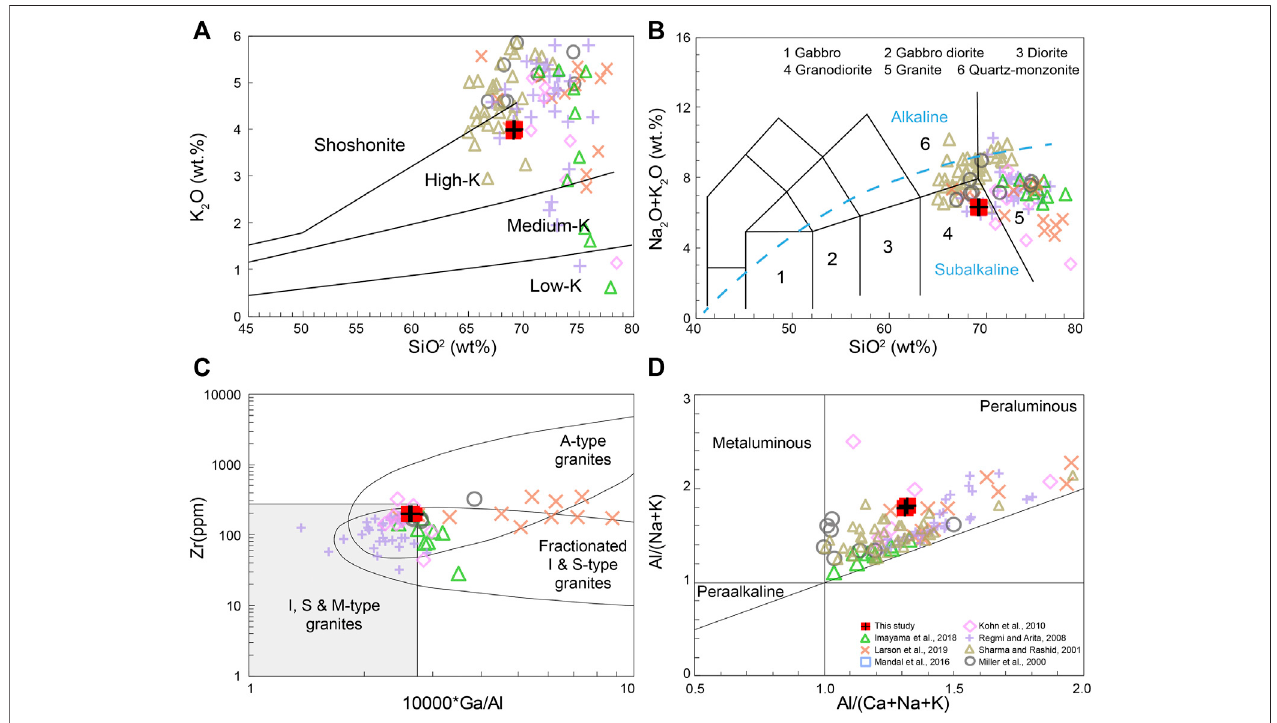
FIGURE 9 | Discrimination diagrams of granite. (A) K 2 O vs. SiO 2 diagram (Irvine and Baragar, 1971); (B) TAS classi fi cation diagram (Middlemost, 1994); (C) diagram of 10000Ga/Al vs. Zr content (Whalen et al., 1987; Wu et al., 2017); (D) ANK vs. ACNK diagram (Maniar and Piccoli, 1989).